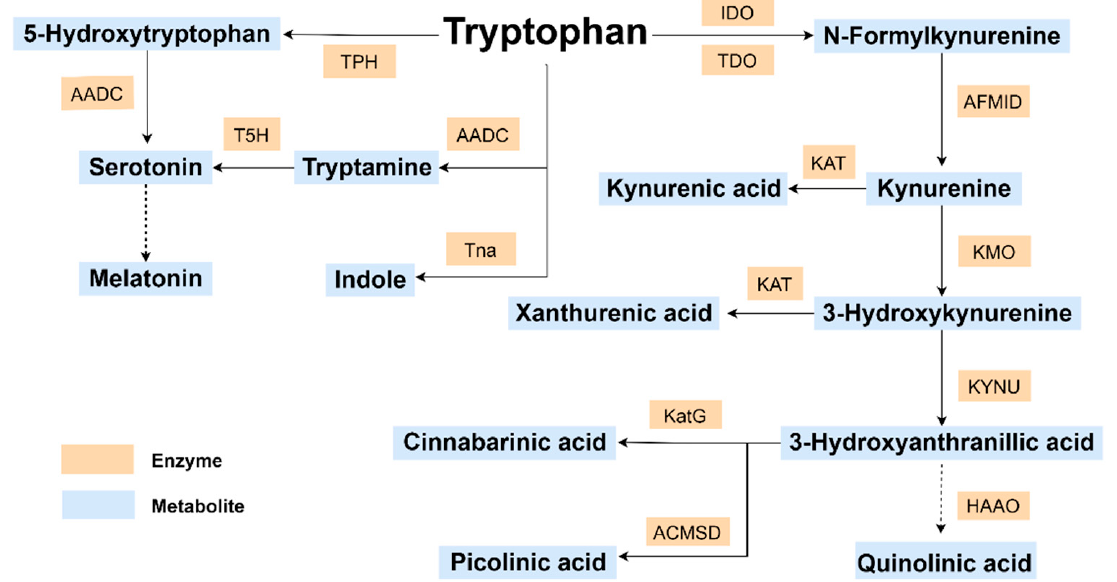
Figure 1. Tryptophan metabolism pathway. Key enzymes: IDO: indoleamine 2,3-dioxygenase; TDO: tryptophan 2,3-dioxygenase; AFMID: arylformamidase; KAT: kynurenine aminotransferase; KYNU: kynureninase; KatG: catalase-peroxidase; KMO: kynurenine 3-monooxygenase; ACMSD: aminocarboxymuconate-semialdehyde decarboxylase; HAAO: 3-hydroxyanthranilate 3,4-dioxy- genase; TPH: tryptophan 5-monooxygenase; T5H: tryptamine 5-hydroxylase; Tna: tryptophanase; AADC: aromatic L-amino acid decarboxylase.